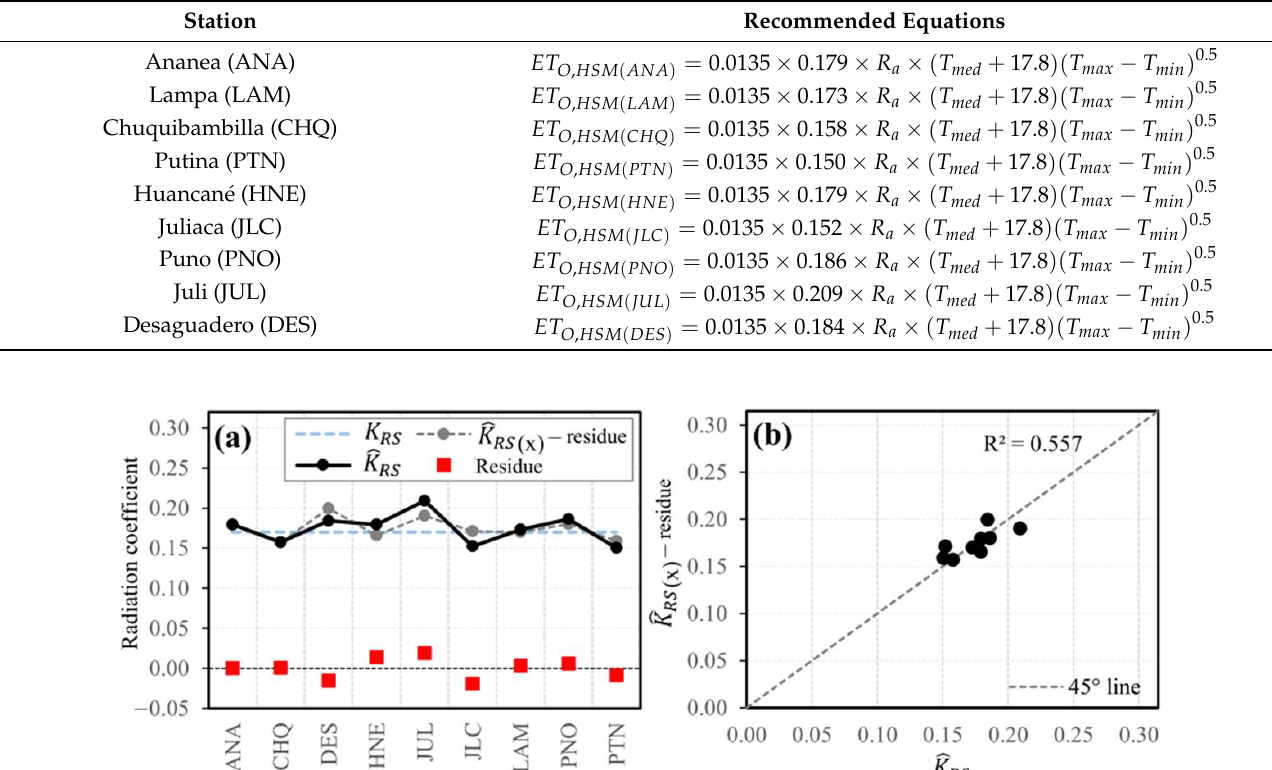
Table 3. Modified HS equations for each weather station.